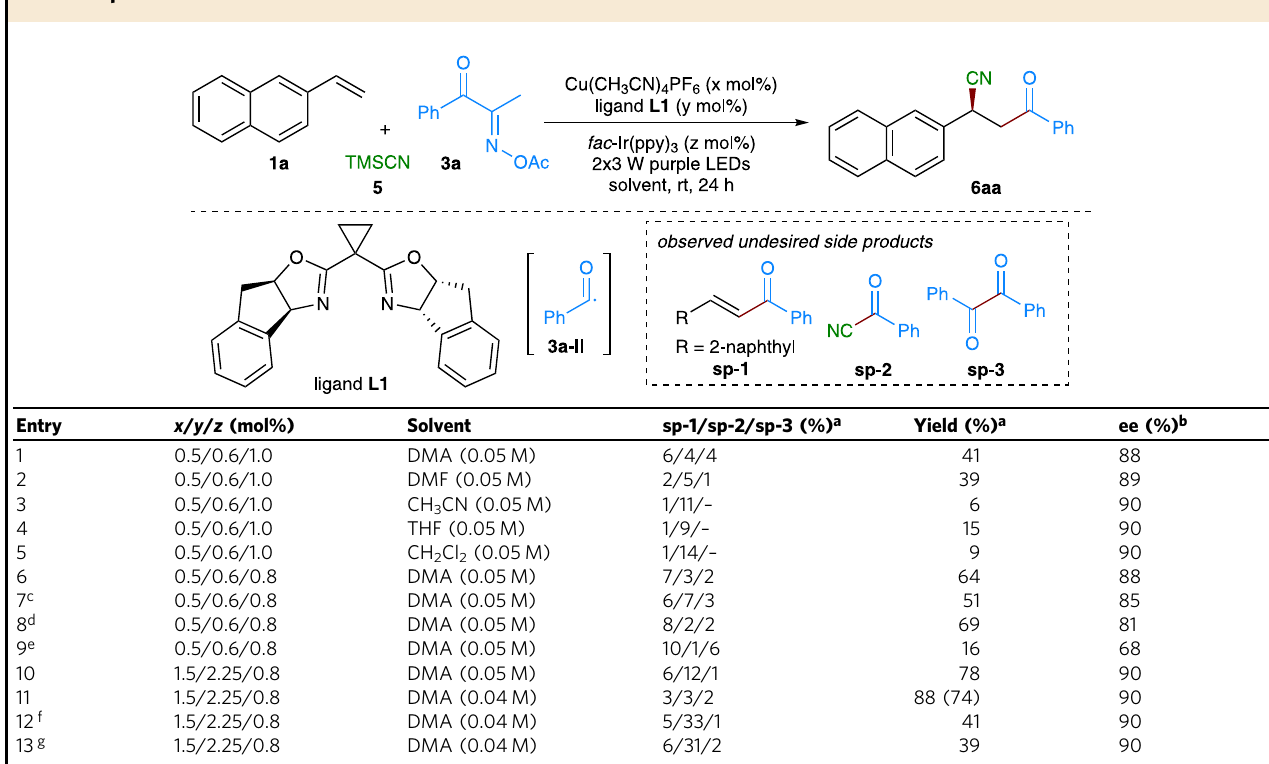
Table 1 Optimization of the reaction